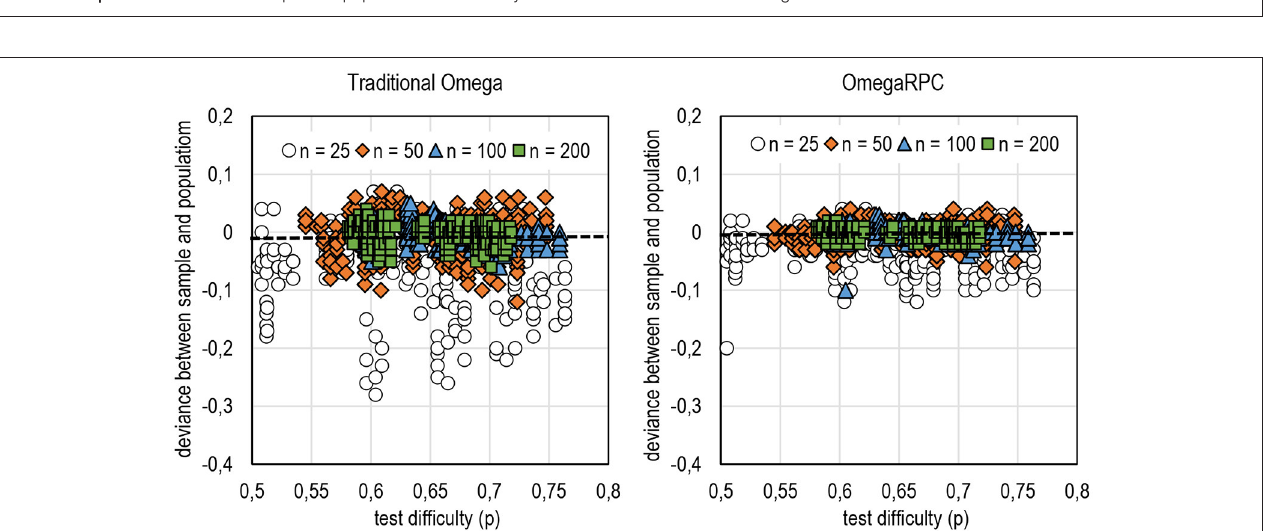
FIGURE 5 | Deviance between sample and population estimates by DCERs based on the form of omega.